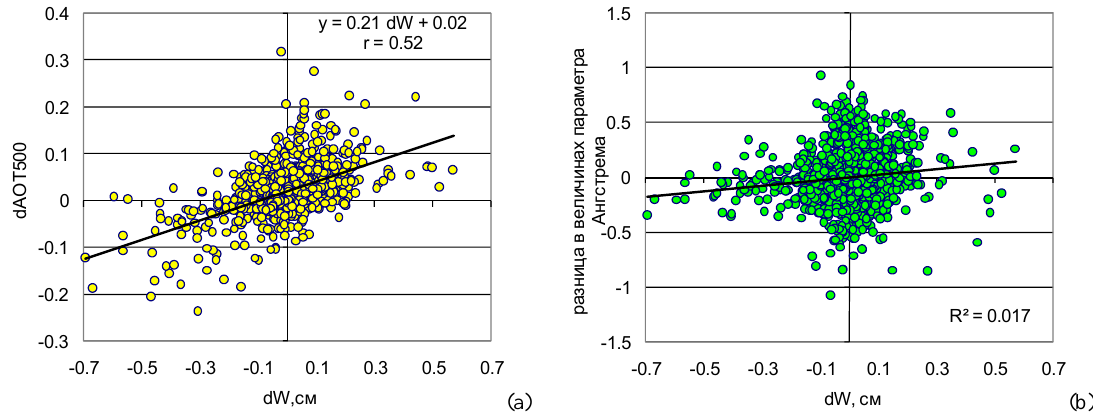
Fig. 4. Correlation between the Moscow-Zvenigorod differences in water vapor dW and aerosol optical thickness d AOT500 (a) , and between differences in water vapor and Angstrom exponent (b) . All – sky conditions.